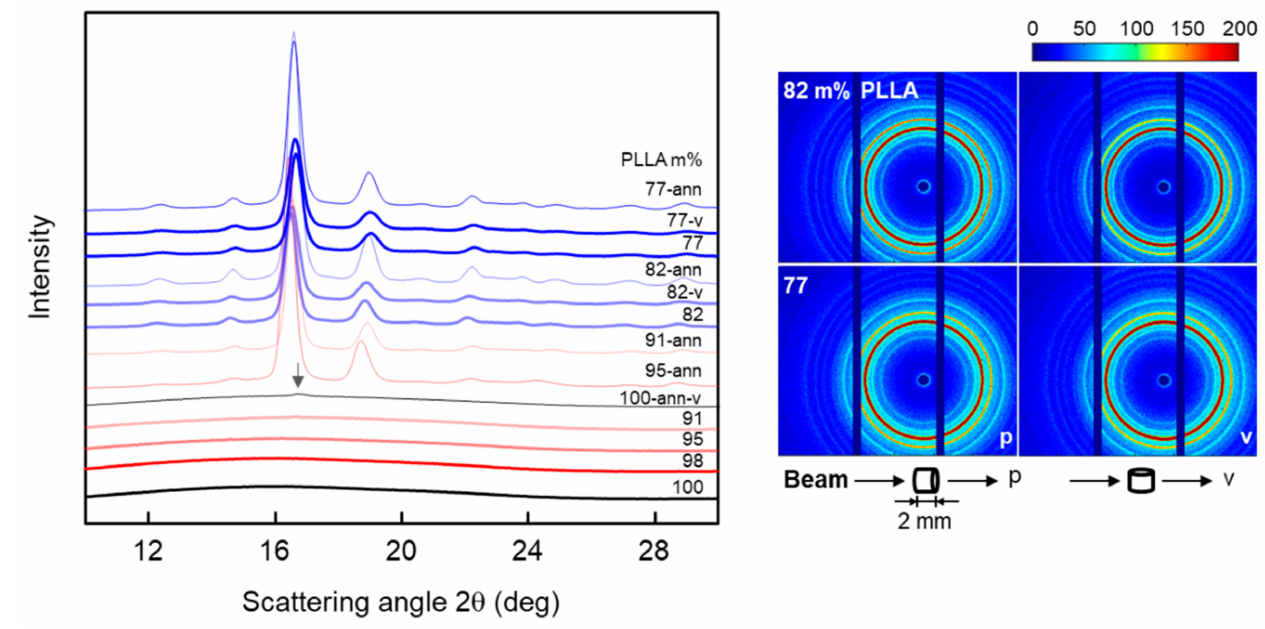
Figure 6. 1D ( left ) and 2D WAXS patterns ( right ) of PLLA/IR3535 extrudates stored at room tem- perature for about 9 months (bold curves), and 1D WAXS patterns of extrudates stored at room temperature for 17 days and additionally annealed at 60 ◦ C for 3–4 weeks (thin curves), with the latter labeled ‘x-ann’ and with x indicating the polymer content in mixture. The cylindrical samples with a diameter of about 2 mm and a length of 2 mm were measured in two directions, with the beam parallel (p) and vertical (v) to the extrusion direction, marked ‘p’ and ‘v’ in the 2D scattering pattern ( right